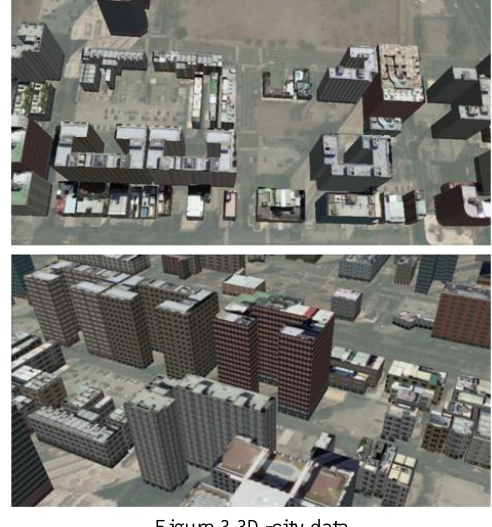
Figure 3 3D-city data